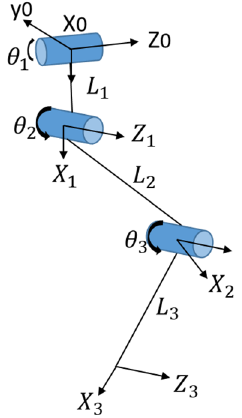
Figure 4. D–H coordinate diagram of leg.